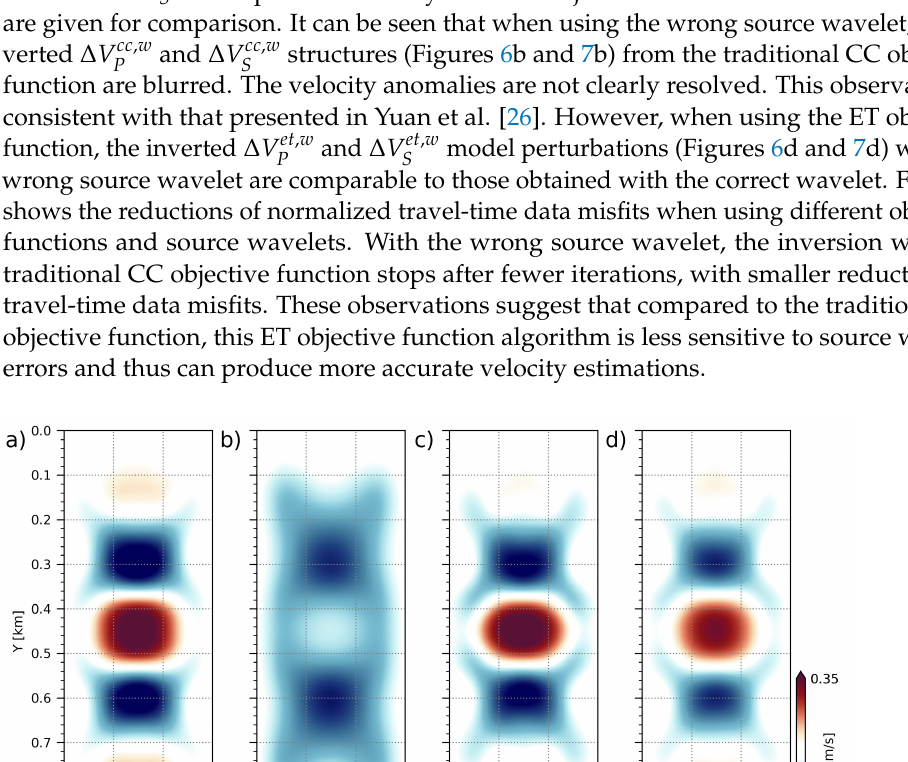
Figure 6. ( a , b ) are the inverted P-wave velocity model perturbations ∆ V cc , c traditional CC objective function with correct and wrong source wavelets; ( c , d ) are the inverted model perturbations ∆ V et , c and ∆ V et , w by the ET objective function with correct and wrong source wavelets. P P